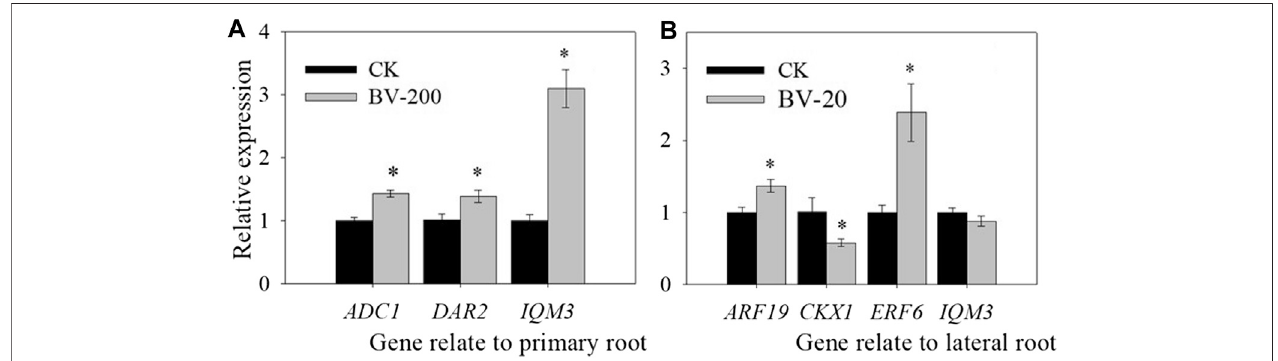
FIGURE 9 | Effect of nanomaterial BV on relative gene expression of primary root length and lateral root numbers in Arabidopsis . (A) Relative gene expression of primary root length. (B) Relative gene expression of lateral root number. CK: Without nanomaterial treatment. 20 and 200 were treated with BV about 20 μ g ml − 1 and 200 μ g ml − 1 .N (cid:2) 3.Errorof fi gurewasstandarderror.Asterisksabovethebarindicatethatthereweresigni fi cantdifferencesbetweenthetwotreatmentsofthegenesat p <